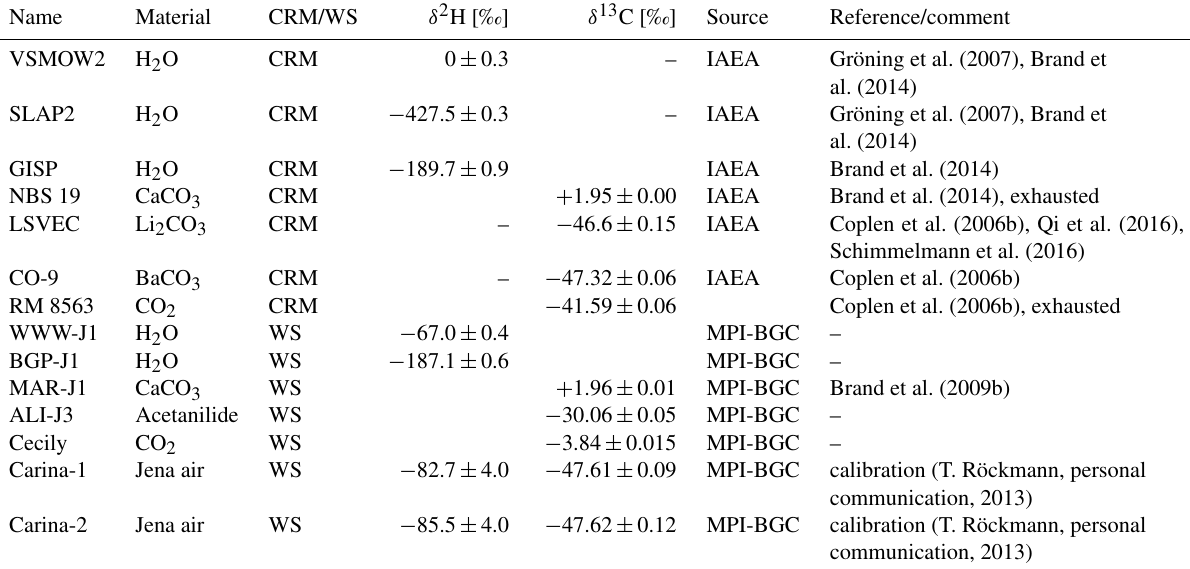
Table 2. Measurement standards used in this study. “CRM” and “WS” identify certified reference material and in-house working standards respectively. The uncertainties of the δ 2 H and δ 13 C data from MPI-BGC correspond to the 95% confidence limit of the error of the mean. We include the uncertainty estimate that the IAEA recently suggested for LSVEC. Publications and additional comments related to the standards are listed in the last